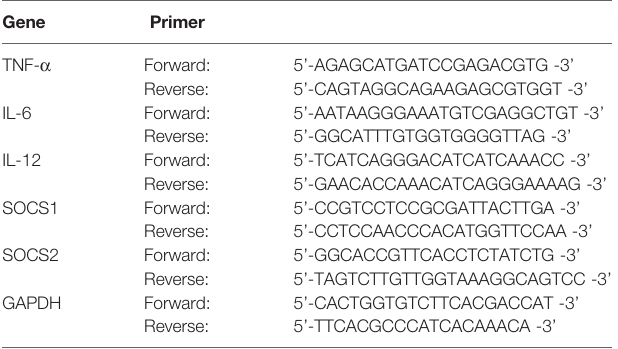
TABLE 1 | Primer sequences for real-time PCR